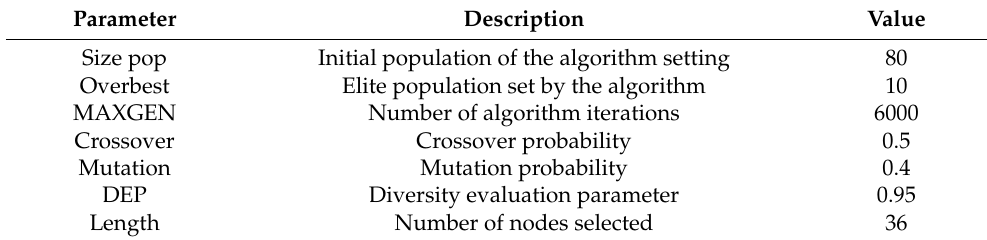
Table 2. Basic parameter settings.